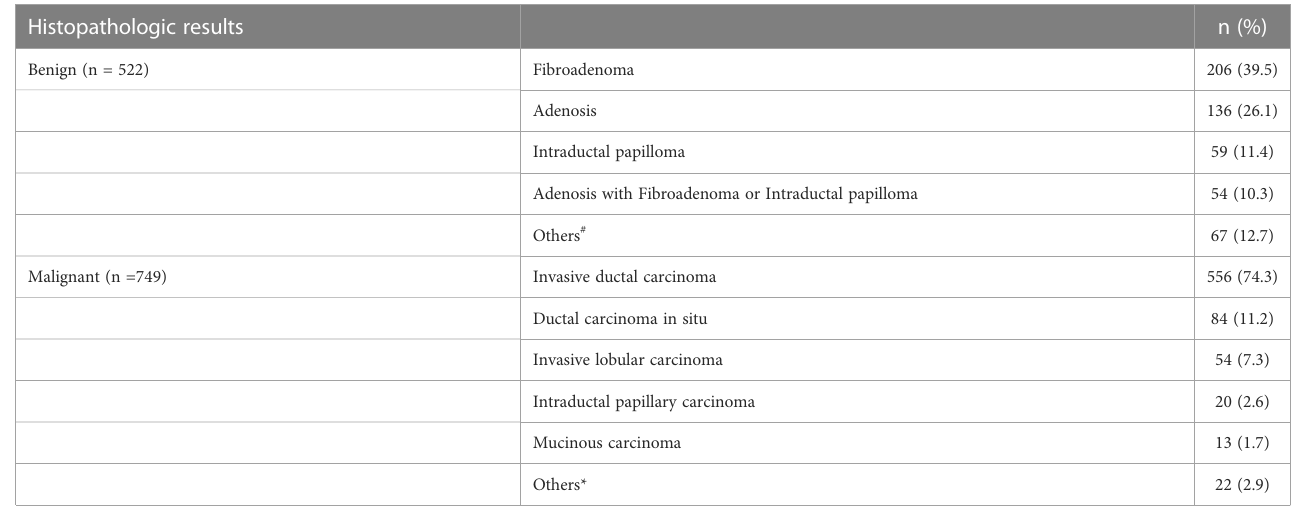
Table 3. Wilcoxon signed-rank tests were conducted, and Pearson ’ s correlation coef fi cients were calculated using geometric features extracted from pairwise comparison metrics in the radiologists ’ segmentations. Wilcoxon tests indicated that the CNN segmentation model satisfactorily matched the performance of the radiologists regarding sensitivity, speci fi city, the Dice coef fi cient, Cohen ’ s kappa, and 95% Symmetric Hausdorff Distance ( P > 0.05).